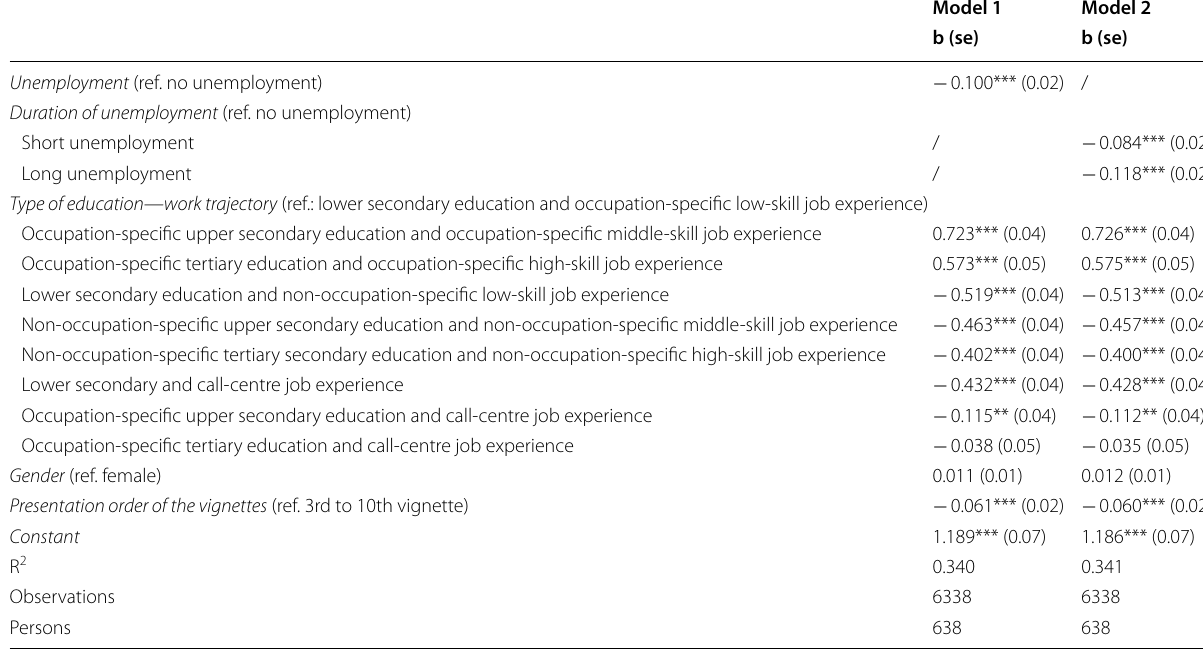
The coefficients are log-transformed vignette ratings and can be interpreted as approximate changes in the percentage points of recruiters’ ratings with a unit change of the independent variable + p < 0.10, * p < 0.05, ** p < 0.01, *** p <